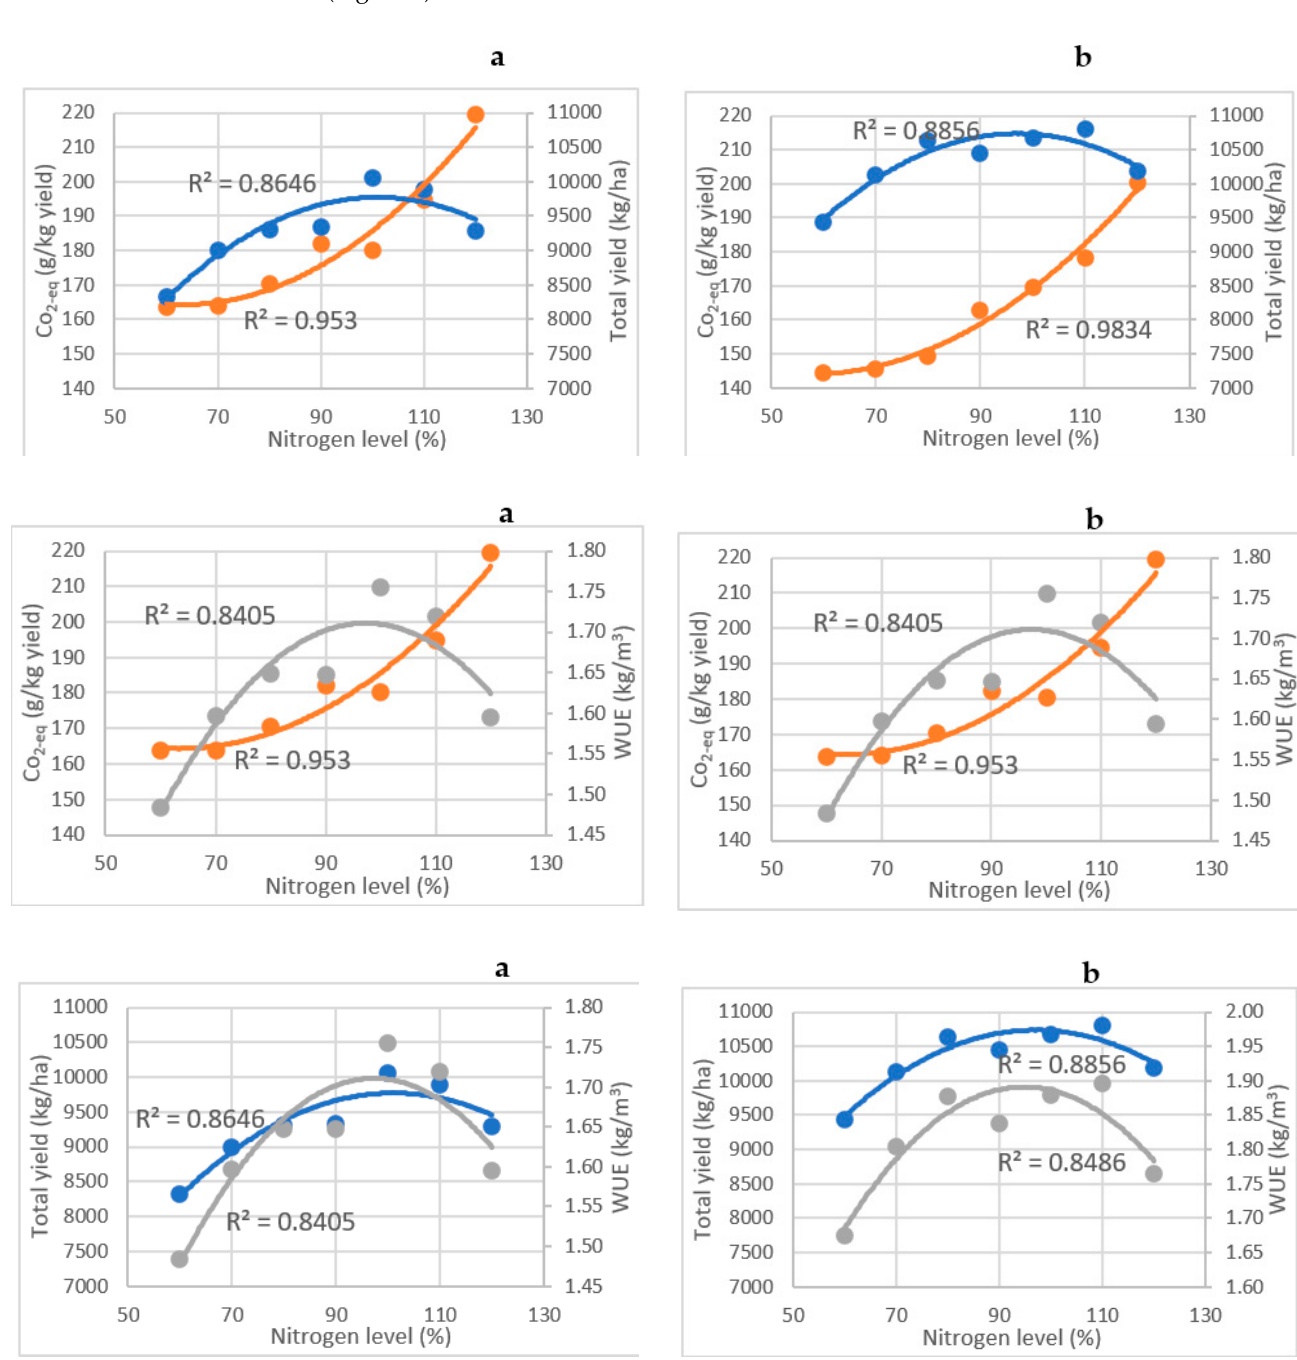
Figure 4. The mean GHG emissions (CO 2-eq “g/kg yield”, orange color), total yield (kg/ha, blue color), and WUE (kg/m 3 , grey color) trend of the applied irrigation systems at the different nitrogen levels (%) at seasons 2019 ( a ) and 2020 ( b ).